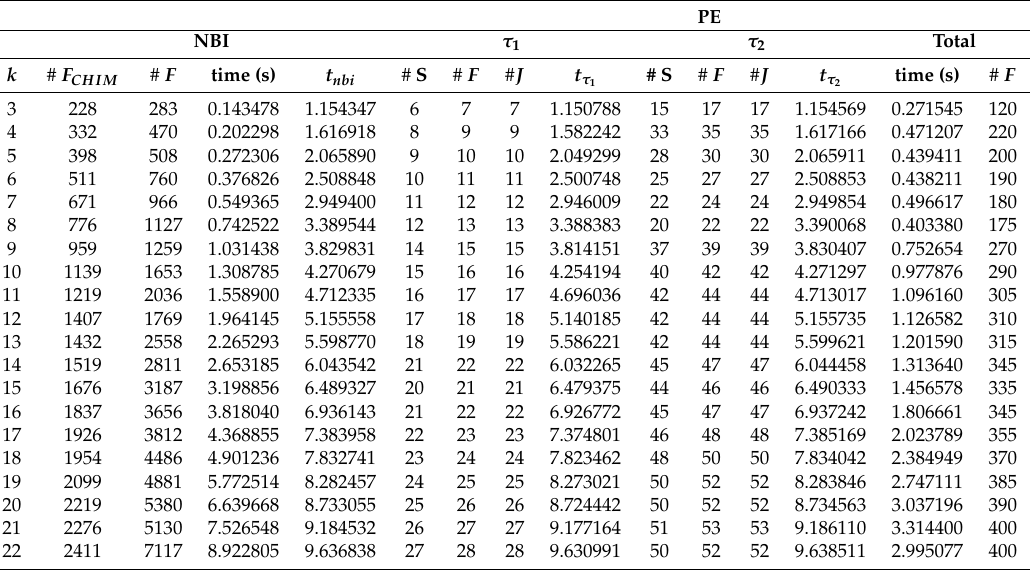
Table 4. Numerical results for the minDTLZ2 for different values of k